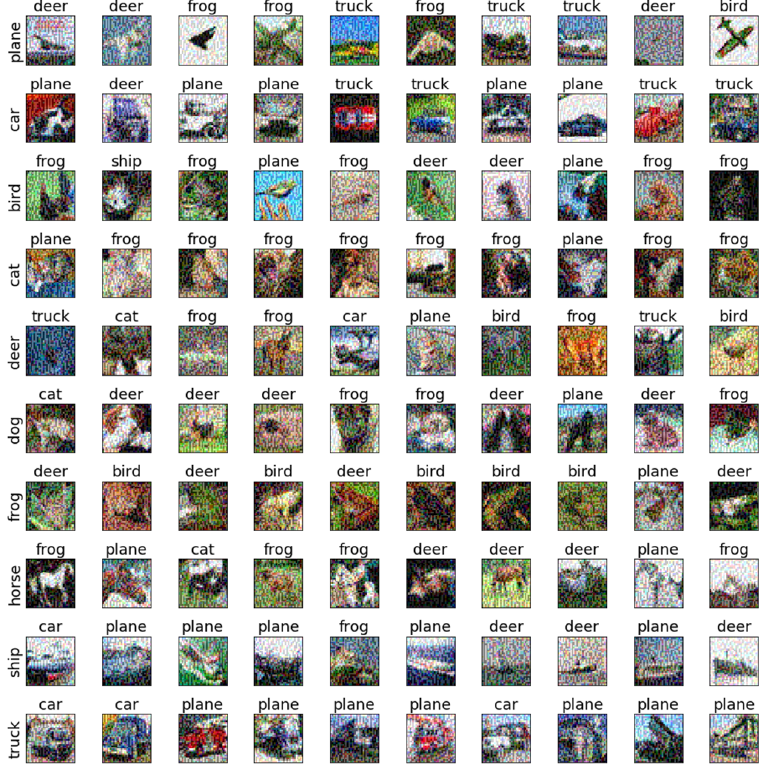
Figure 13. The adversarial examples of SAGM for Cifar10 and AlexNet.